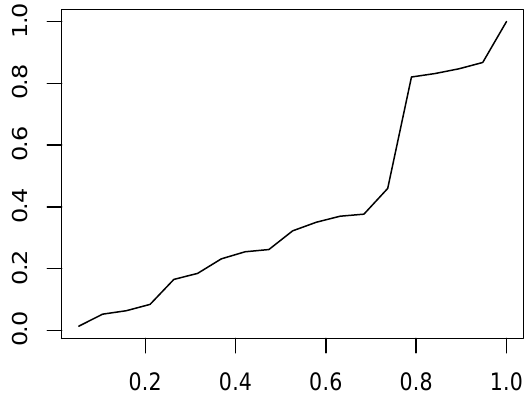
Figure 5. The empirical TTT Plot for Example 2.